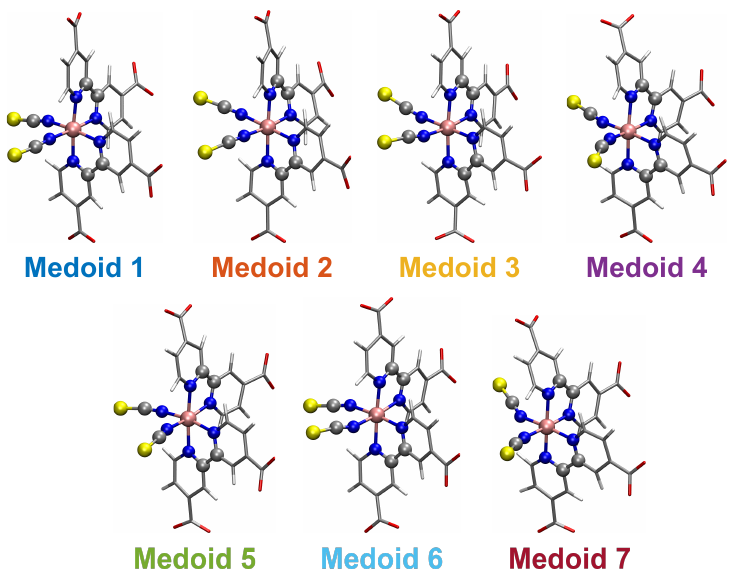
Figure 8. Structures of the N3 4 − seven cluster medoids. The atoms determining the features employed for clustering analysis are highlighted as ball and stick. The color code is uniform with that of Figure 7. Table 3. Clustering feature values of the seven cluster medoids from N3 4 − trajectory. φ 1 :